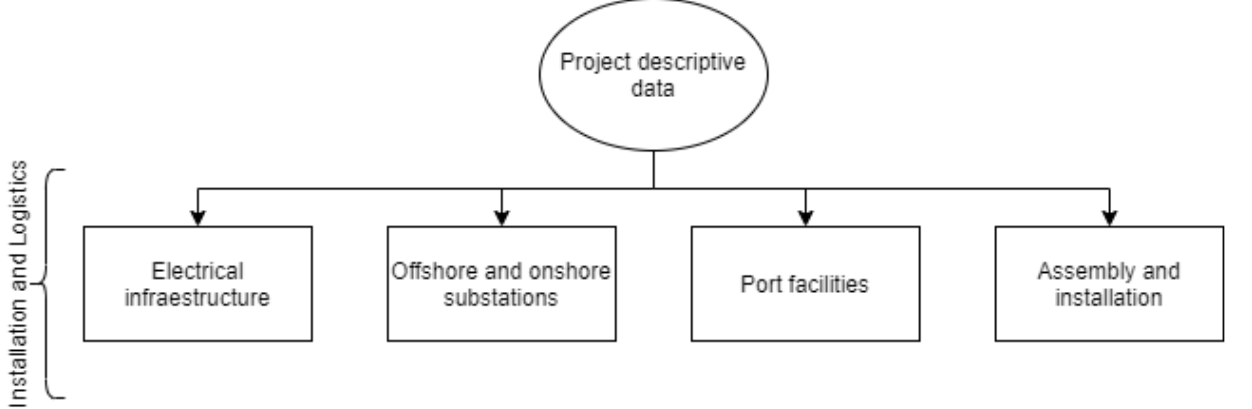
Figure 2. Main aspects addressed with this tool.